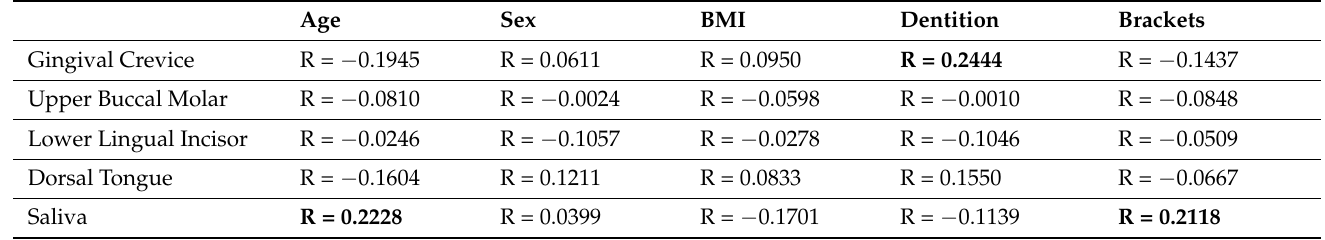
Table 3. Correlation of variables to SW-positive site-specific screening